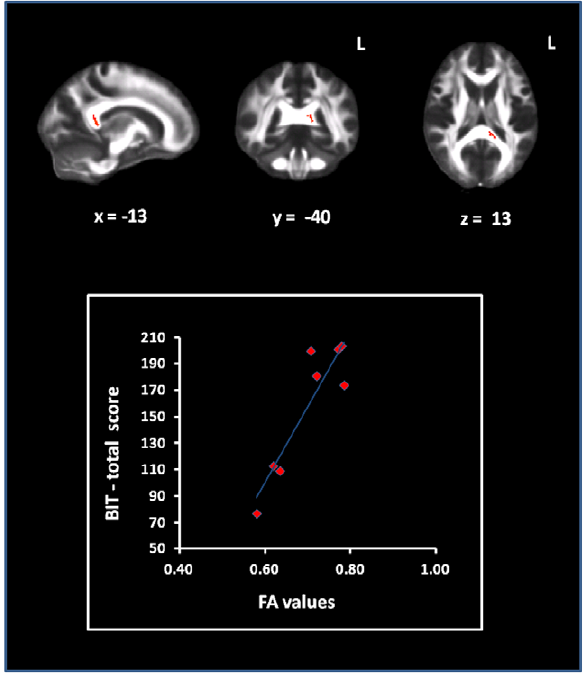
Figure 4. Correlation between patients’ FA and BIT scores. In top panel it is illustrated the region of the posterior corpus callosum , whose fractional anisotropy (FA) value correlates with patients’ performance at Behavioural Inattention test (BIT). In the bottom panel, the FA values extracted from that region are plotted, patient by patient, against their correspondent performance obtained at BIT. The post-hoc R value (Pearson correlation coefficient) was 0.91.